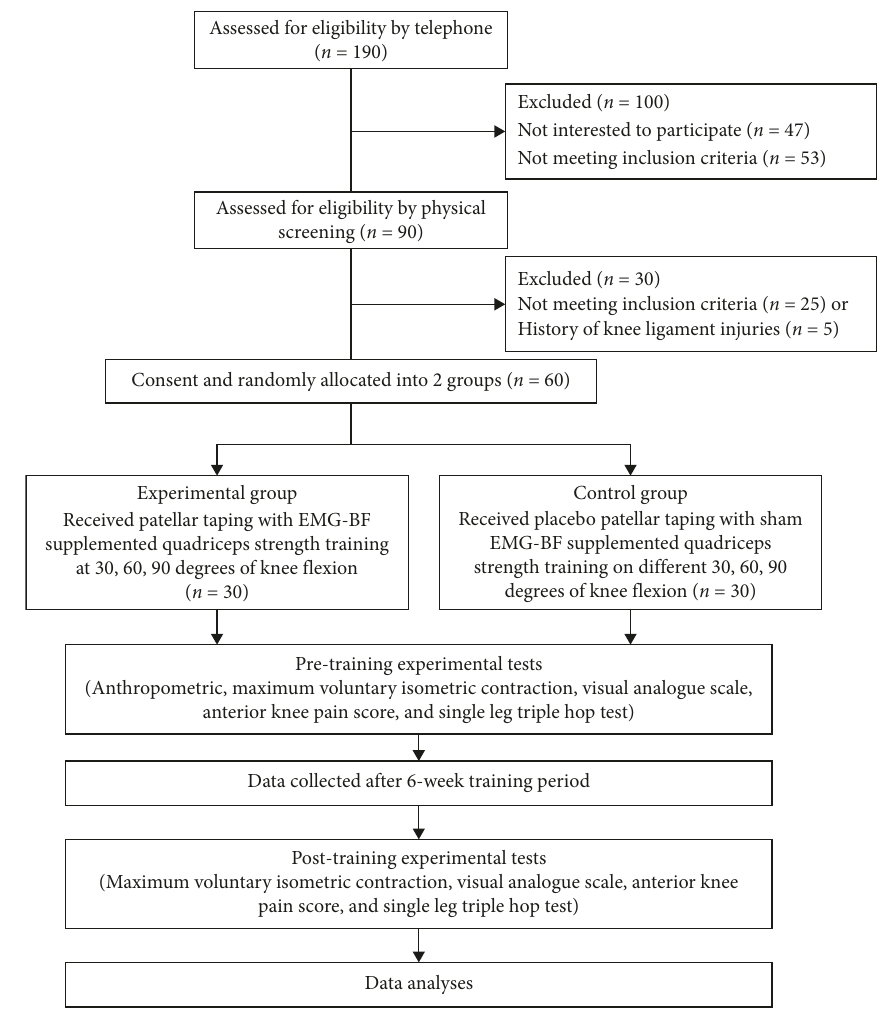
Figure 1: Participants’ flow through each stage of a randomized trial Consolidated Standards of Reporting Trials (CONSORT)